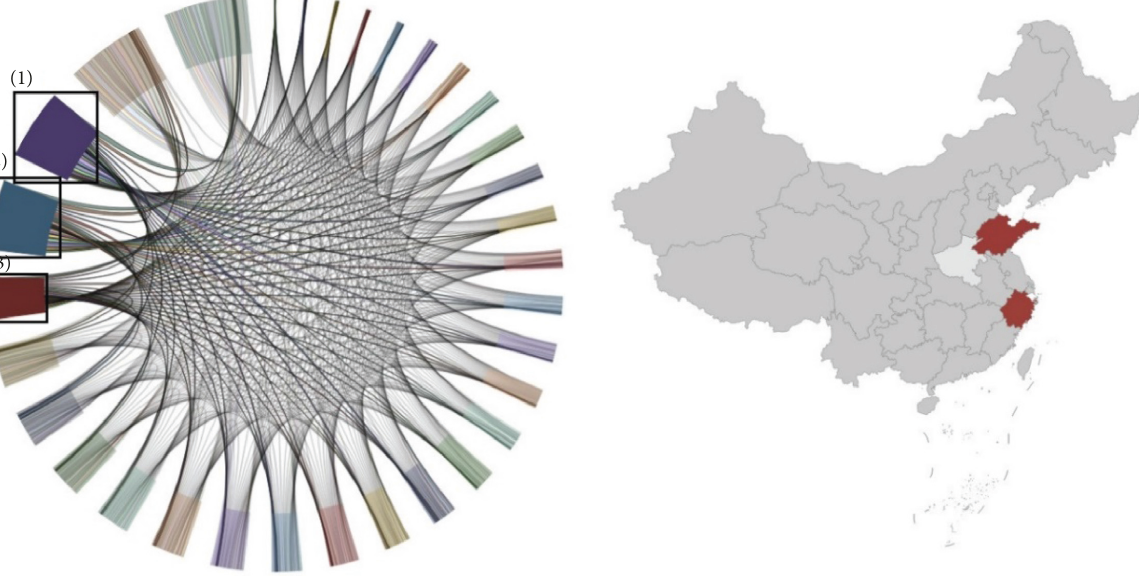
Figure 25: Linkage analysis of commodity